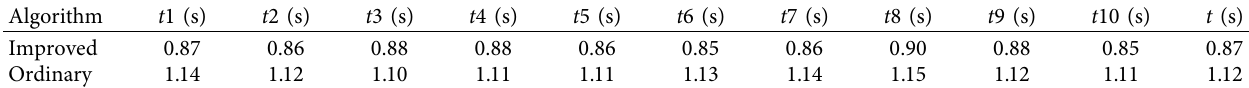
Table 1: The average operation time of both algorithms.